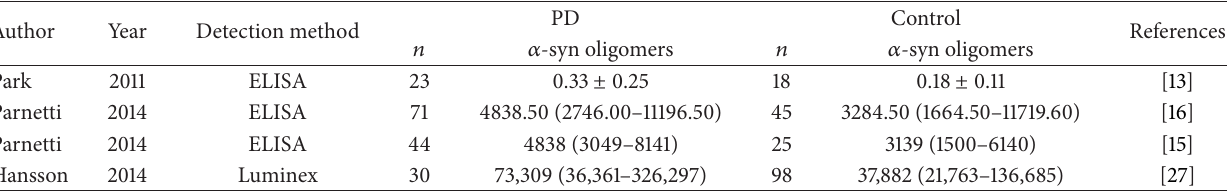
Figure 2: Flow diagram of the study selection process in the meta-analysis of 𝛼 -syn oligomers. Table 2: Summary of studies included in the systematic review ( 𝛼 -syn